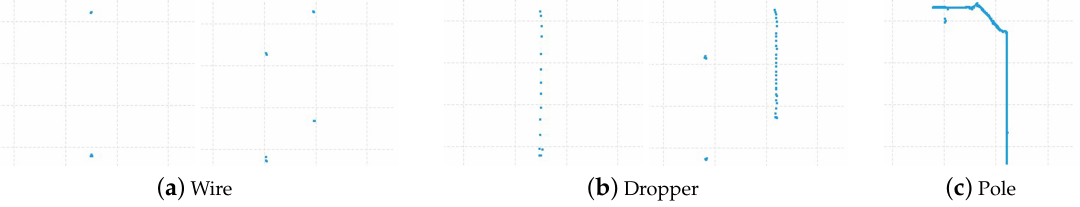
Figure 4. Context of the projection of a single frame point clouds onto the XY plane.